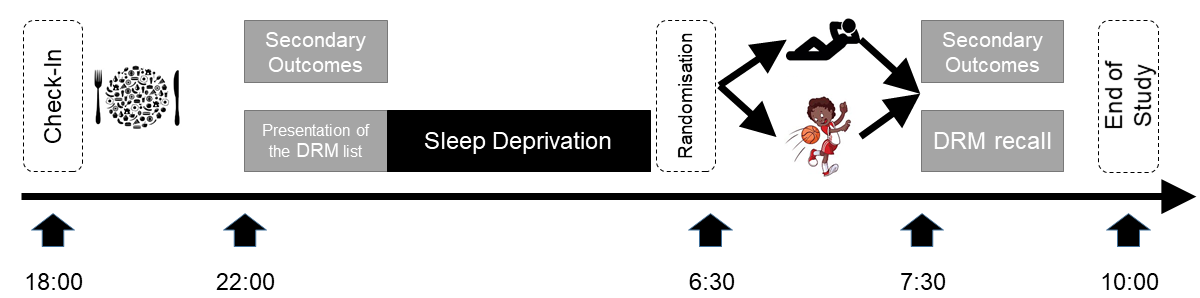
Figure 1. Study Design. A single-center randomized controlled study investigating the effects of a 20-min moderate-to-vigorous circuit training (see icons) on parameters of cognitive performance when compared to a passive control. Participants checked in at 18:00 the day of the experiment, starting with a collective standardized Mediterranean dinner. Baseline parameters were assessed at 22:00, and thereafter the list of Desse, Roediger and McDermott (DRM) words was presented [27]. In the following night, sleep loss of the participants was assured by the study team. At 6:30 participants were randomized into two groups with the “exercise group” leaving to a nearby gym where they participated in an exercise program, whereas the “control group” remained passively seated in the common area. At 7:30 all outcomes were re-assessed, the DRM word were recalled, and the study ended thereafter.